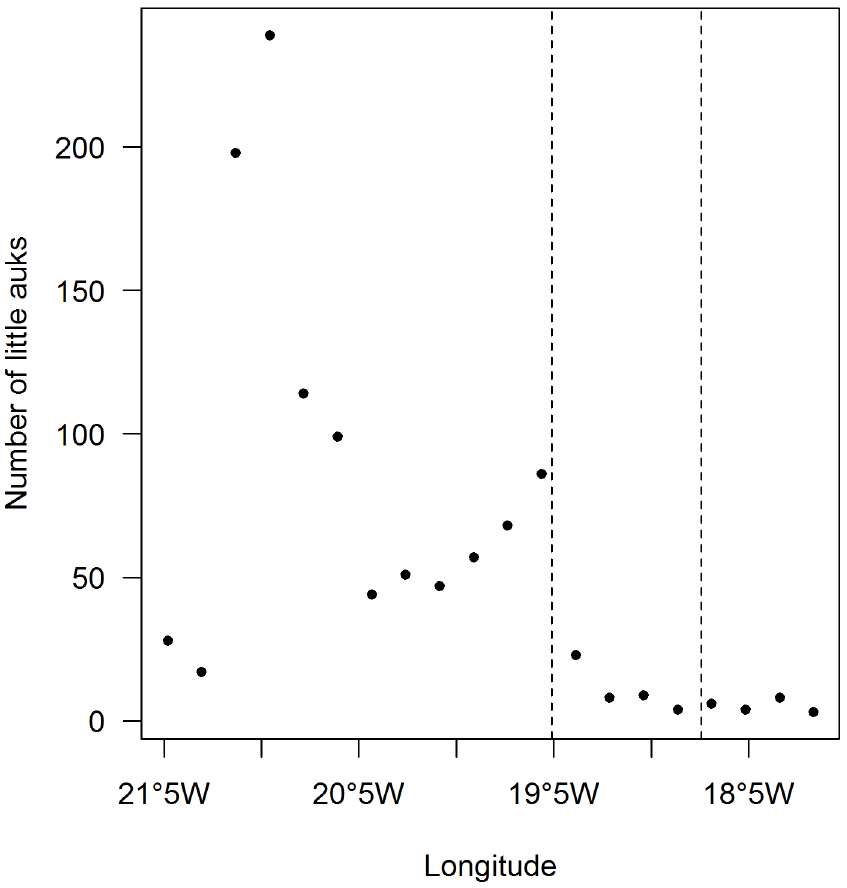
Fig 4. At-sea little auk sightings in 2014, in the absence of sea ice. Data from the two transects (Fig 5) were pooled and counts were grouped according to longitude. The two dashed lines represent the longitude of the 500 m and 1500 m isobaths, which delimit the shelf